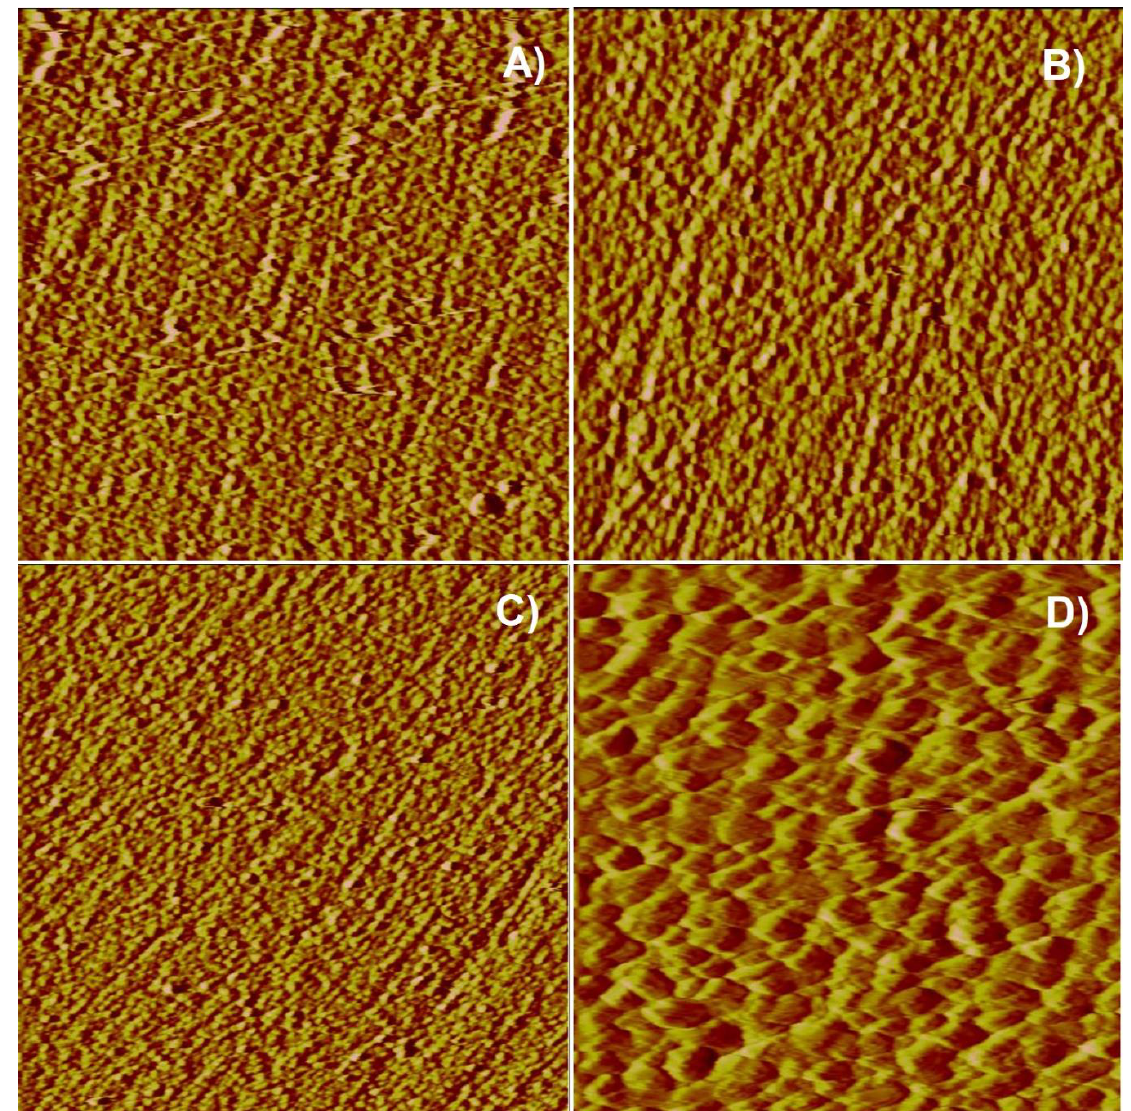
Figure 13. AFM height images (5 µm × 5 µm) with a data scale of 20 nm of a bornite surface soaked in the 1 × 10 − 4 M PAX solution at pH 10 ( A ) for 5 min, ( B ) for 10 min, ( C ) for 20 min and ( D ) for 20 min (1 µm × 1 µm).